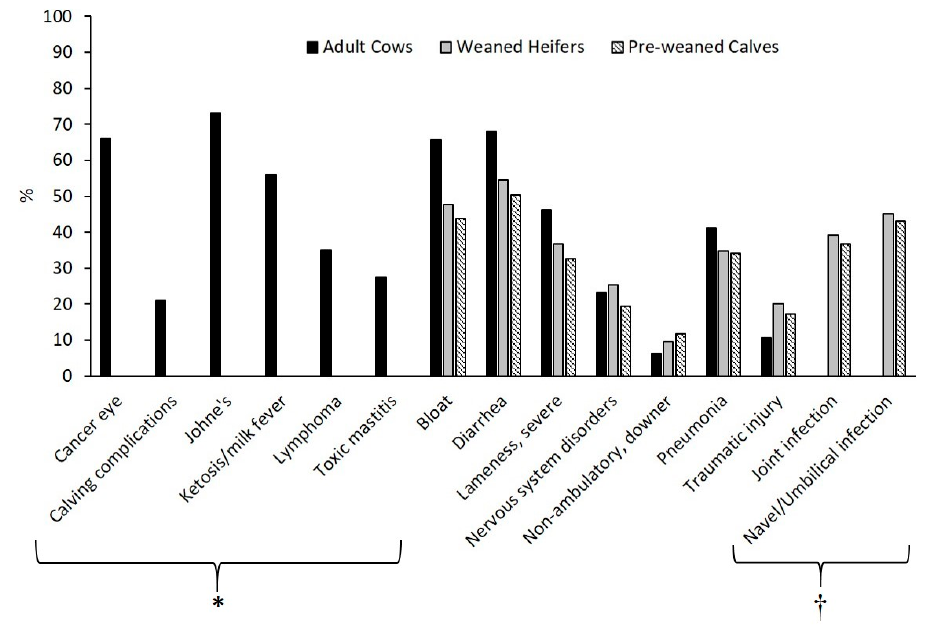
Figure 3. The percentage of respondents who, after choosing the T / M condition management option, indicated that they would never euthanize due to these conditions alone for adult cows, weaned heifers and pre-weaned calves. * These conditions ( n = 6) were only included for adult cows. † These conditions ( n = 2) were only included for weaned heifers and pre-weaned calves.